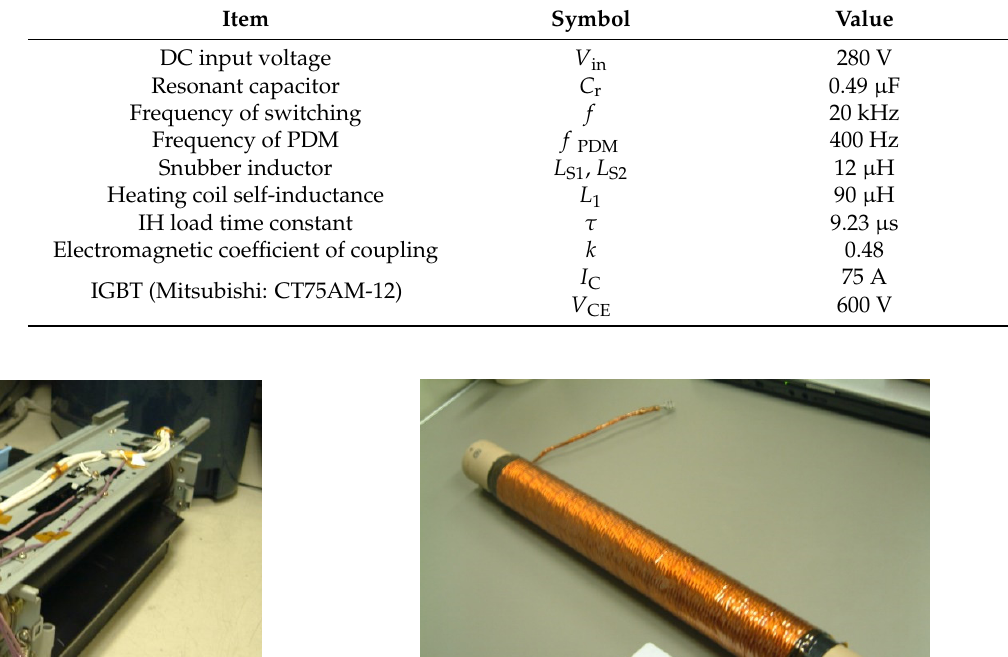
Figure 6. IH fixed roller and heating coil. ( a ) Fixed roller. ( b ) Heating coil.